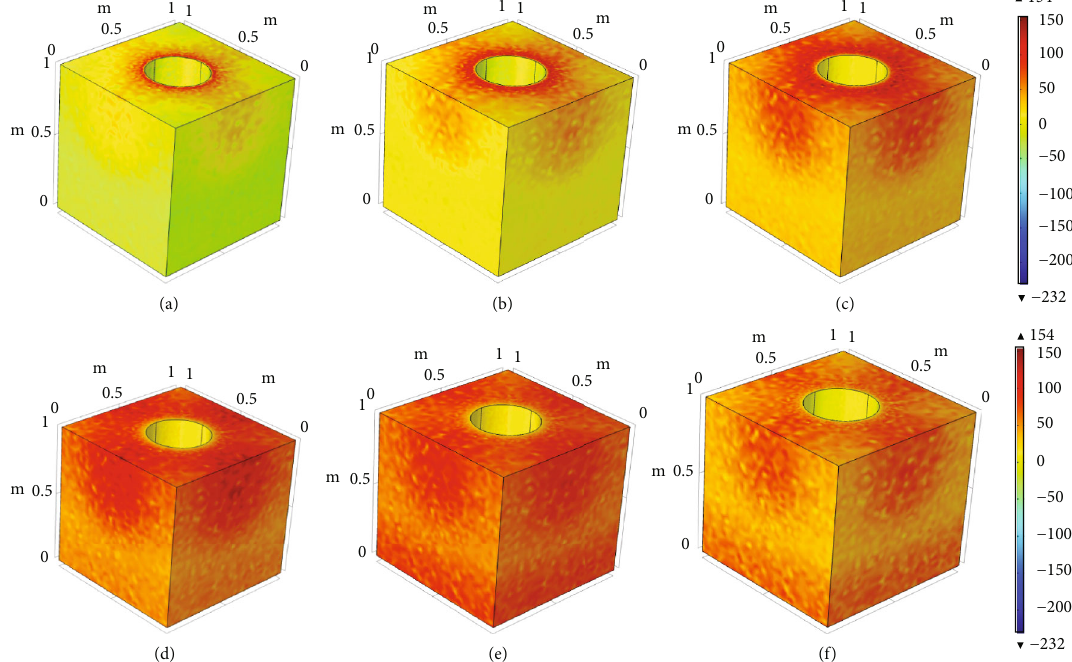
Figure 11: Stress fi eld in the m = 7 coal rock: (a) t = 0 : 1 s, (b) t = 1 × 10 3 s, (c) t = 1 × 10 4 s, (d) t = 1 × 10 5 s, (e) t = 1 × 10 6 s, and (f) t = 1 × 10 7 s.